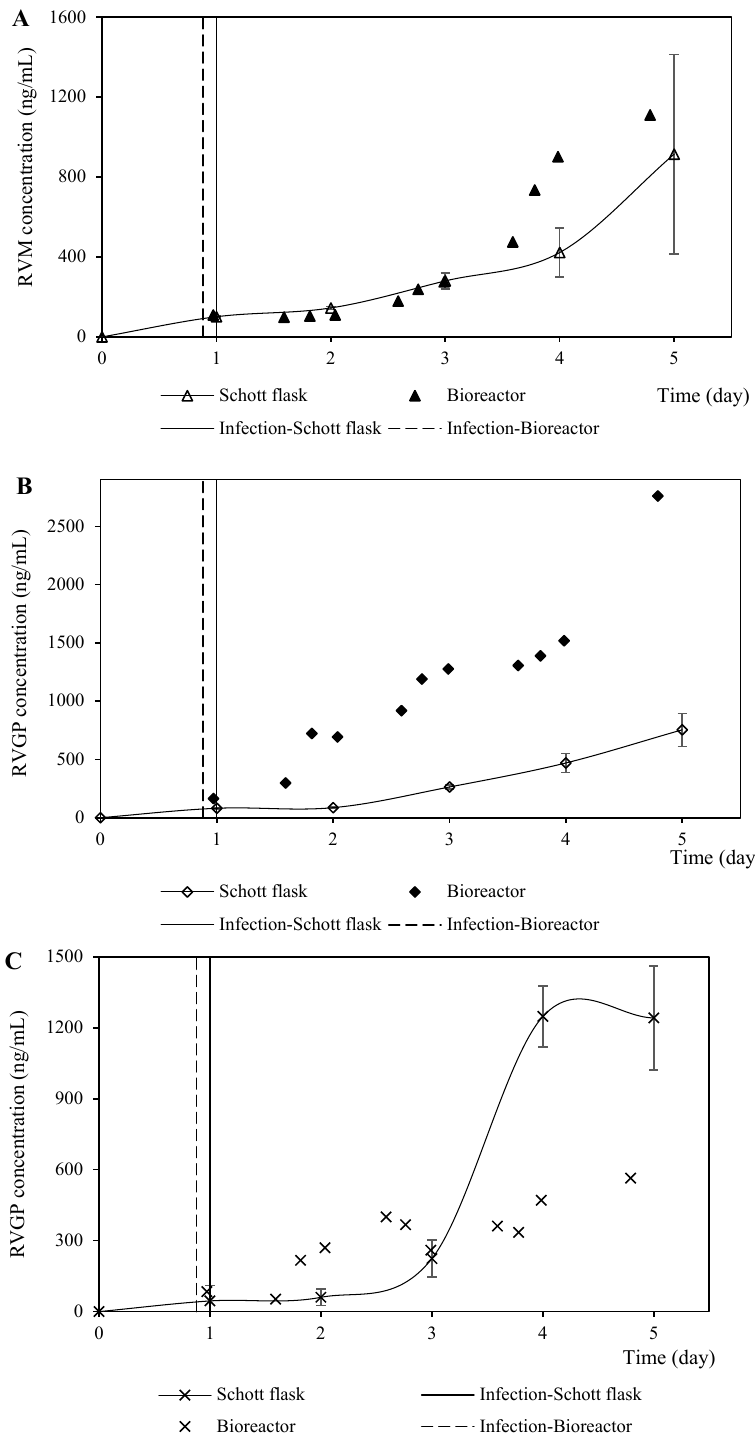
Figure 8. Rabies protein expression profiles from coinfection performed in Schott flasks and bioreactor at BVM MO of 2.0 pfu/cell and a BVG/BVM MOI ratio of 1.5. ( A ) Kinetics profiles of rabies matrix protein (RVM) production (measured by the signal intensity of the dot blot membrane labeled with anti ‐ RVM antibody). ( B ) Kinetics profiles of rabies G glycoprotein (RVGP) production (measured by the signal intensity of the dot blot membrane labeled with anti ‐ RVGP antibody). ( C ) Kinetics profiles of rabies G glycoprotein (RVGP) production (measured by ELISA).